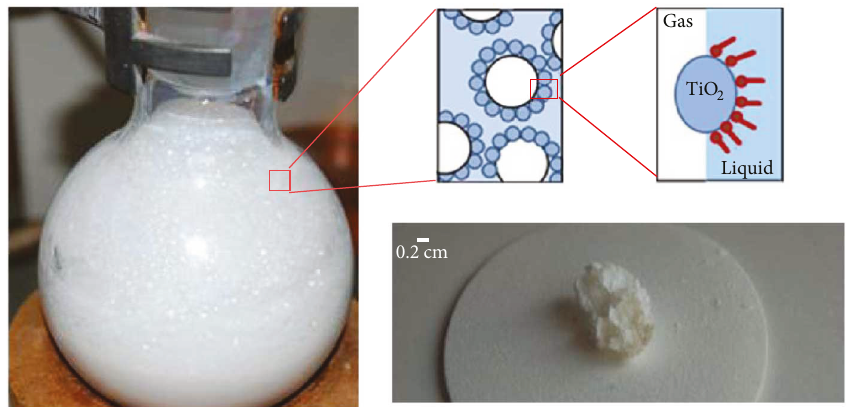
Figure 1: Photographs of wet particle-stabilized foams and a schematic illustration of the stabilization of gas bubbles with partially hydrophobized colloidal particles to fi nally obtain the TiO 2